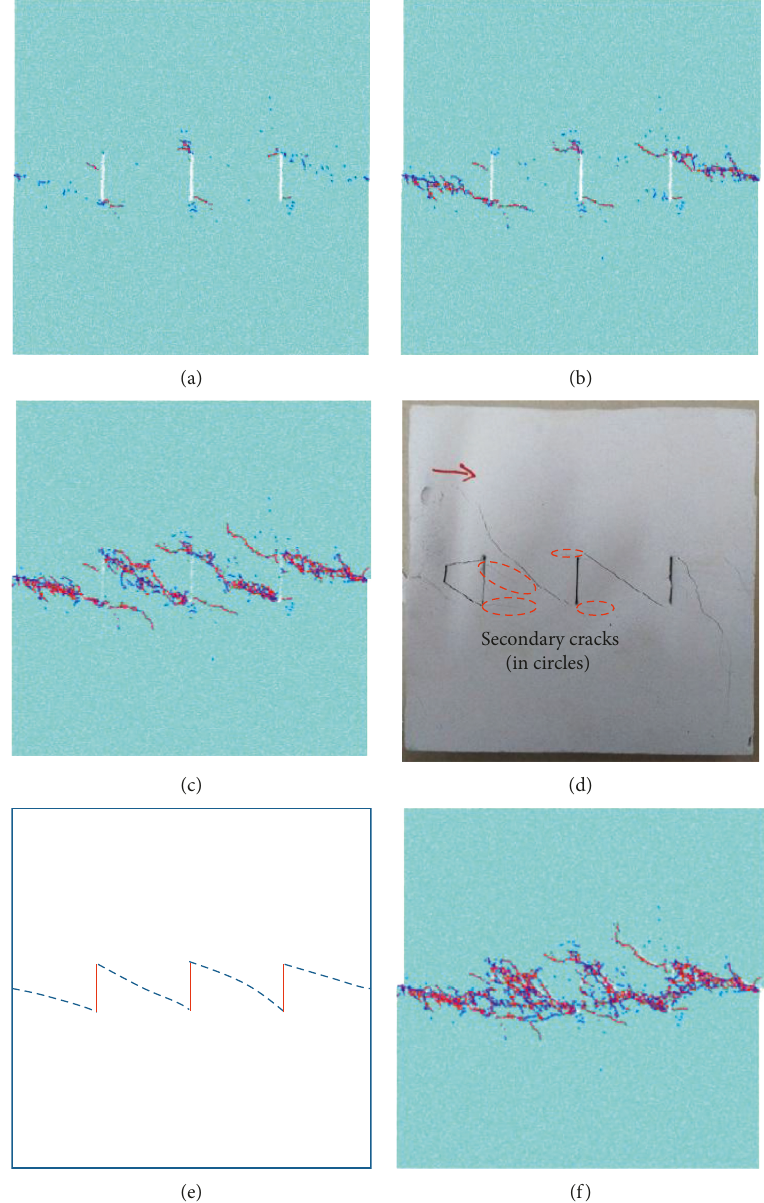
Figure 16: Fracturing process of Sample B90. (a) Point A. (b) Point B. (c) Point C. (d) Real failure. (e) Multiple sawteeth. (f) Point